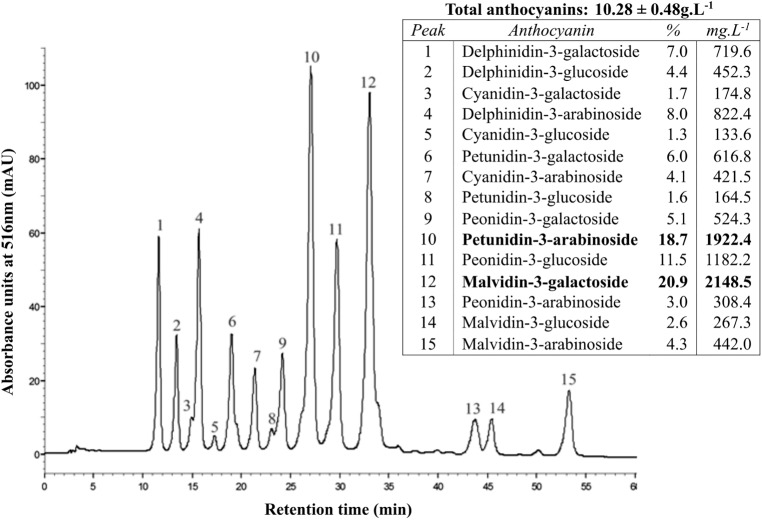
HPLC-DAD chromatogram of blueberry anthocyanin-rich fraction.The peak identification and the contents of the different anthocyanins are indicated in the inset table.